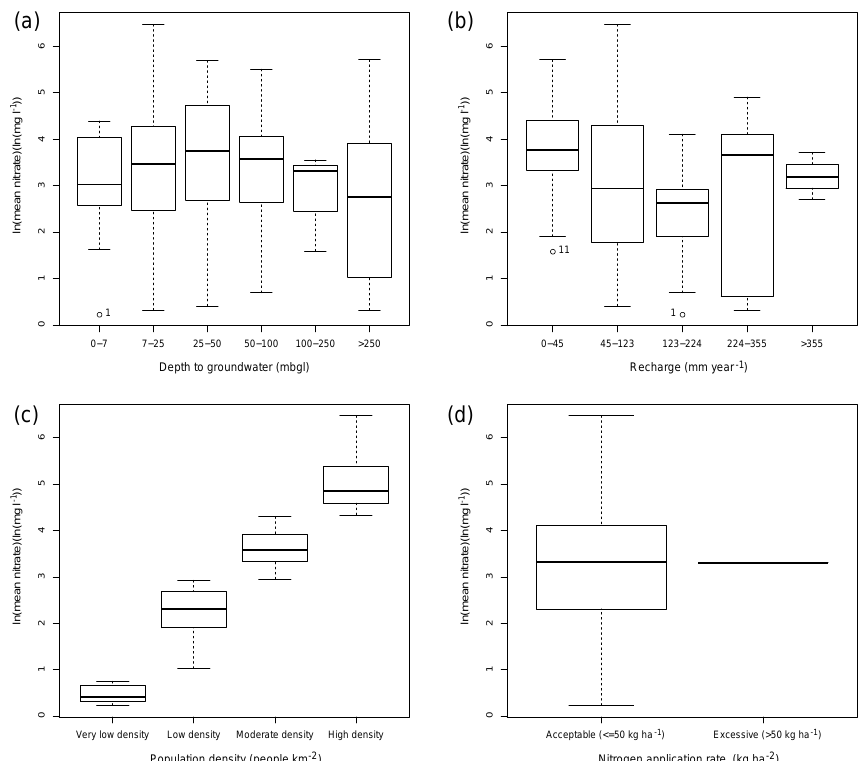
Figure 8. Log transformed mean nitrate concentration for different groundwater depth classes (a) , recharge classes (b) , population density classes (c) and nitrogen application rate classes (d)